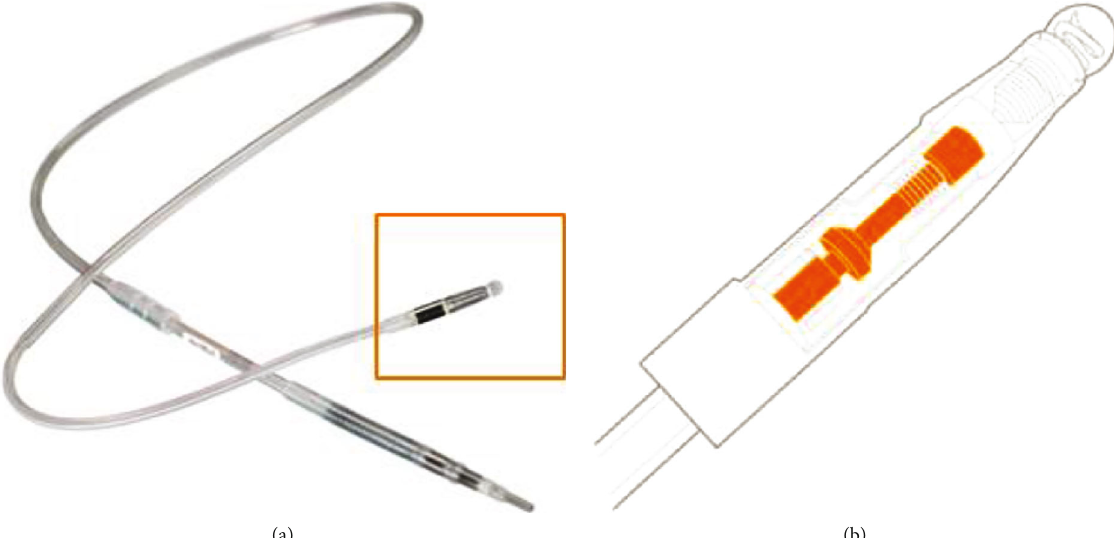
Figure 1: A SonRtip atrial lead with SonR hemodynamic sensor embedded in the tip (a) and a cross-section of the lead tip showing the sensor ’ s location inside the tip